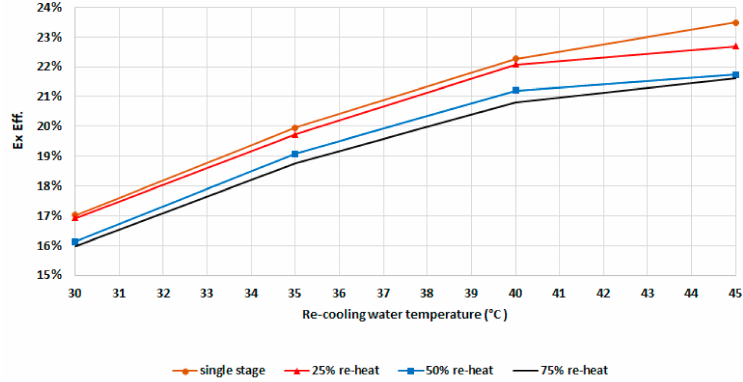
Figure 14. Exergetic efficiency for the chiller components at different